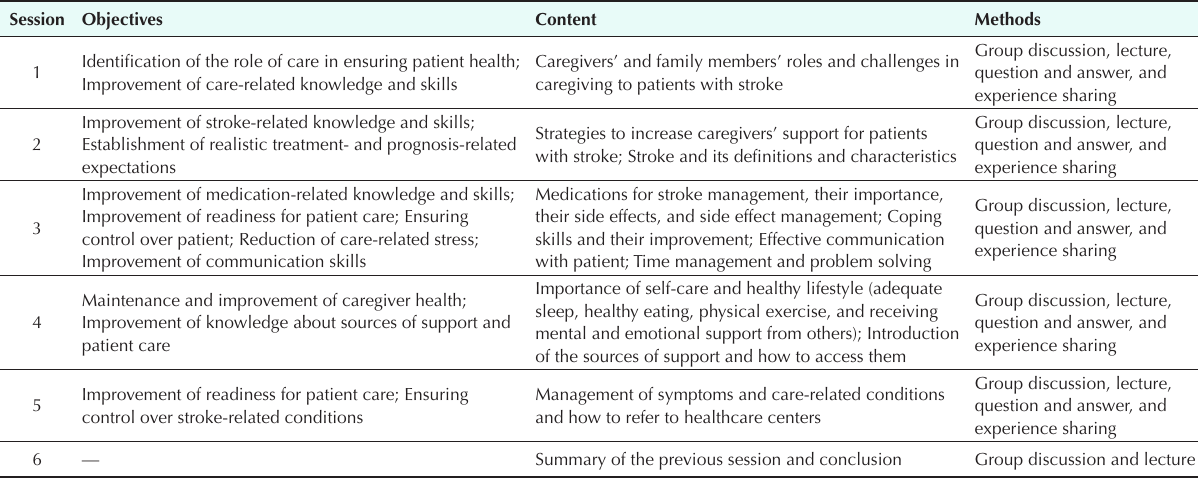
Table 1. The characteristics of the study intervention Session Objectives